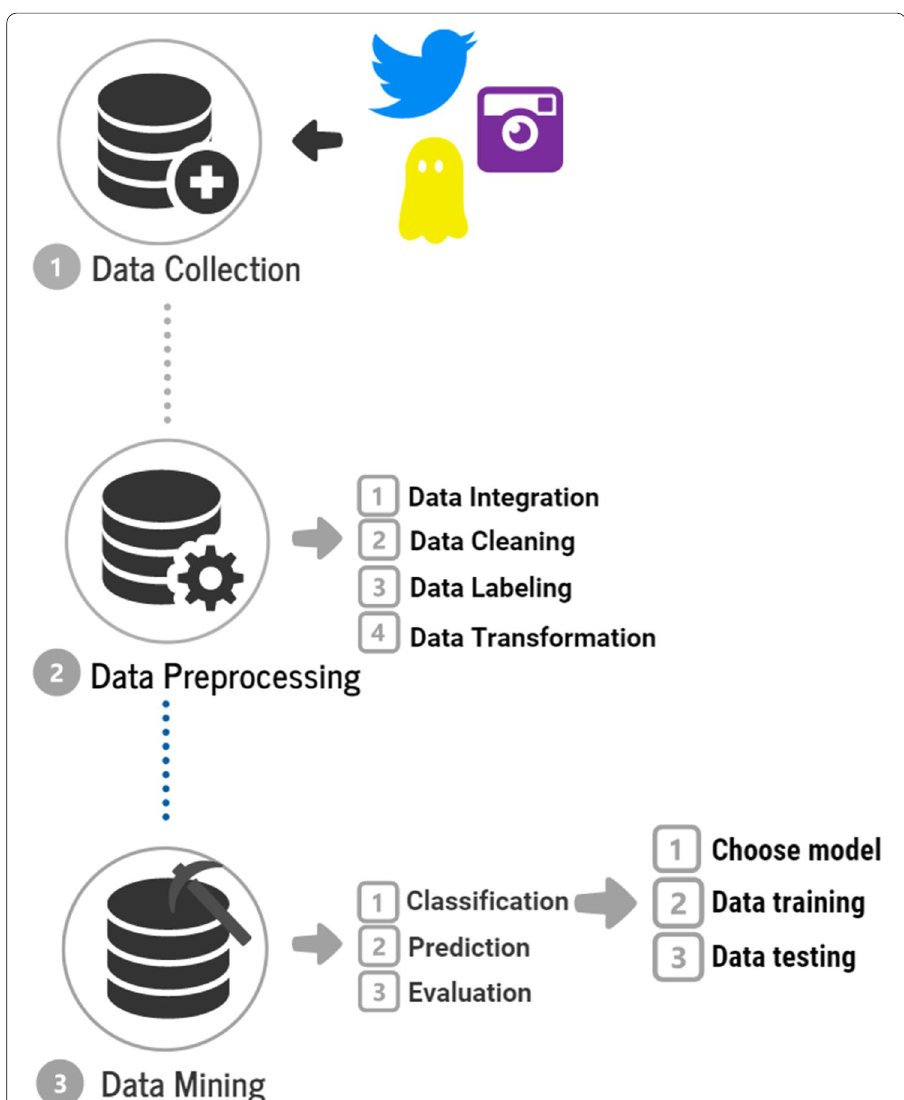
Fig. 6 The data mining process